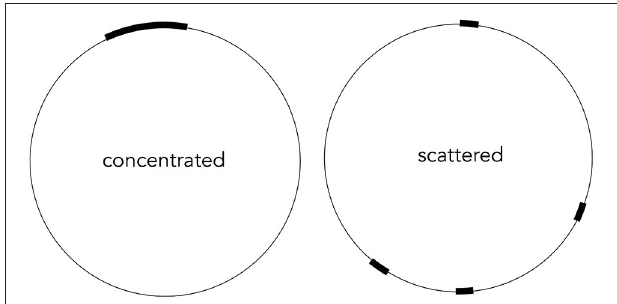
FIGURE 3 | Frequency distributions of the number of random reads for 200 and 500 insertion lengths.